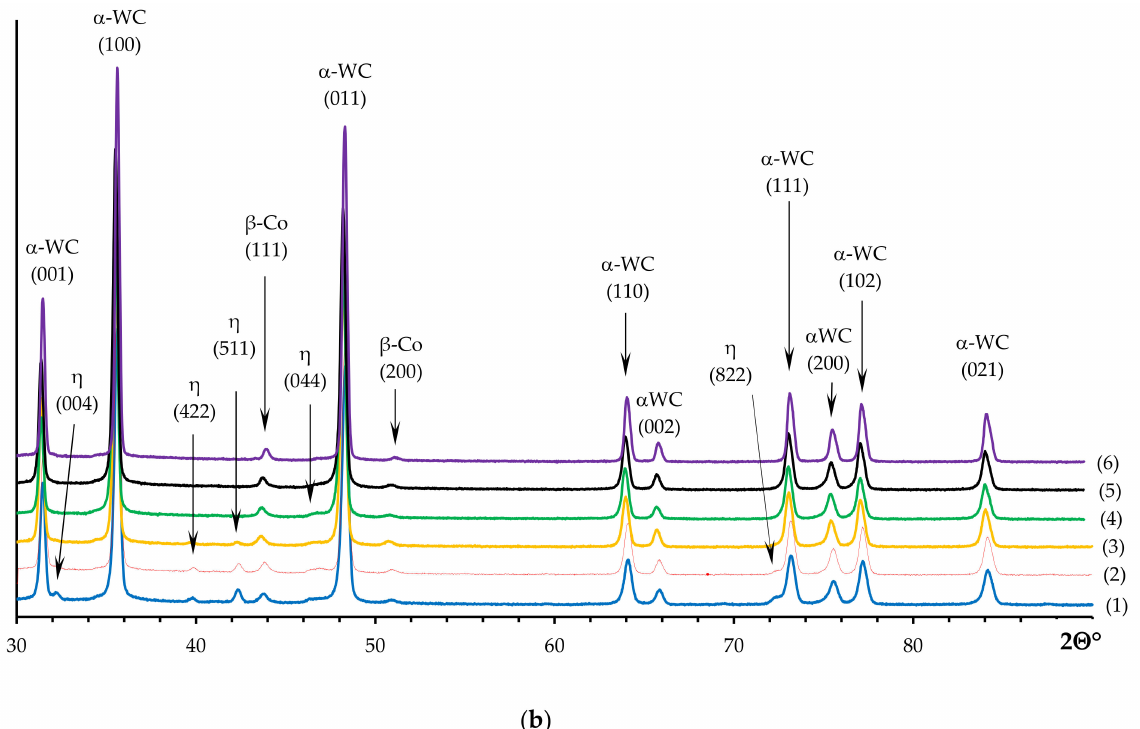
Figure 6. XRD results for WC-10Co specimens with various graphite concentrations obtained by solid-phase ( a ) and liquid-phase ( b ) SPS: Line (1)—0 wt.%, (2)—0.1 wt.%, (3)—0.2 wt.%, (4)—0.3 wt.%, (5)—0.4 wt.%, (6)—0.5 wt.%